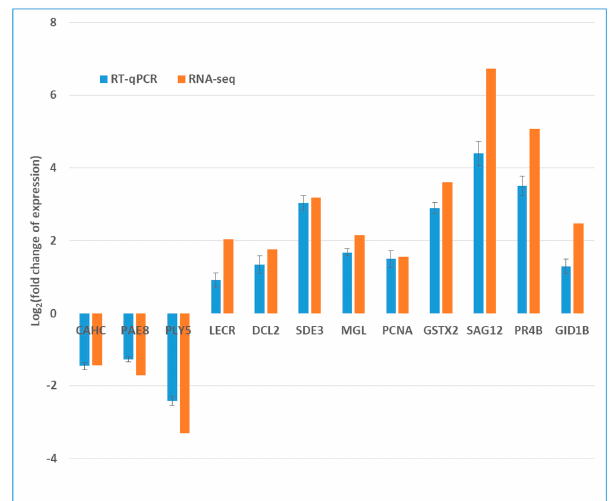
Figure 5. Validation of RNA-seq results by quantitative real-time PCR (RT-qPCR). Expression patterns of 12 representative genes as determined by RT-qPCR and RNA-seq. Normalization for RT-qPCR was performed using expression of the actin gene as an internal reference. CAHC: Carbonic anhydrase, chloroplastic; PAE8: Pectin acetylesterase 8; PLY5: Pectate lyase 5; LECR: Lectin-related protein; DCL2: Endoribonuclease Dicer homolog 2; SDE3: Silencing defective 3; MGL: Methionine gamma-lyase; PCNA: Proliferating cell nuclear antigen; GSTX2: Glutathione S-transferase; SAG12: Senescence-specific cysteine protease SAG12; PR4B: Pathogenesis-related protein PR-4B; GID1B: Gibberellin receptor